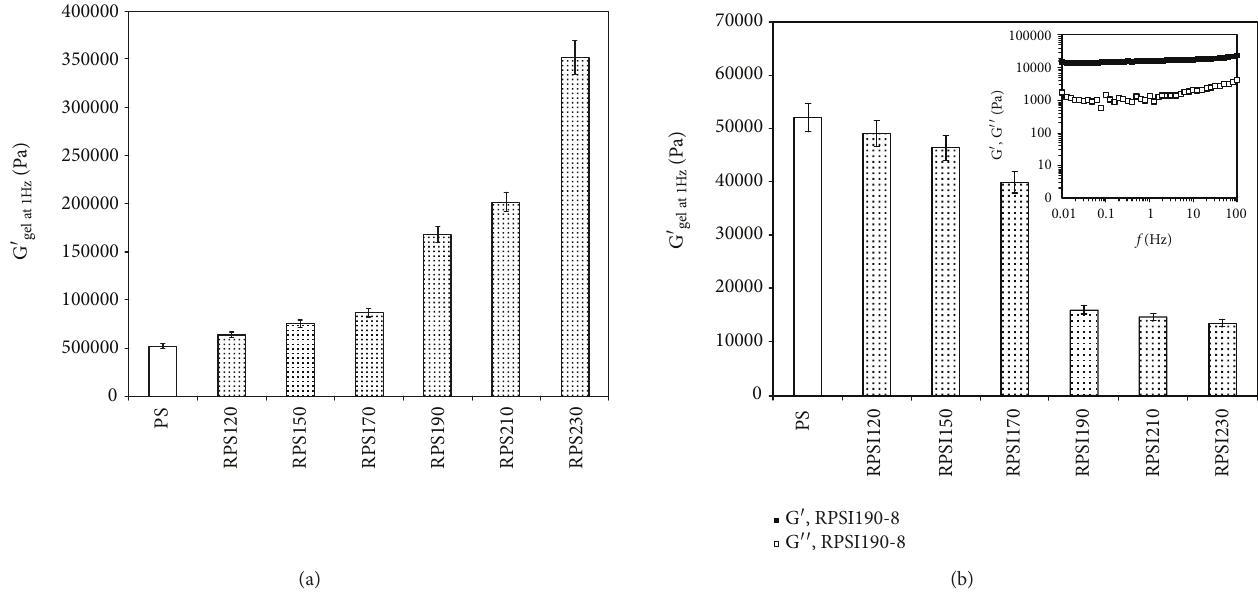
at 1Hz, Pa) without (a) and with gel